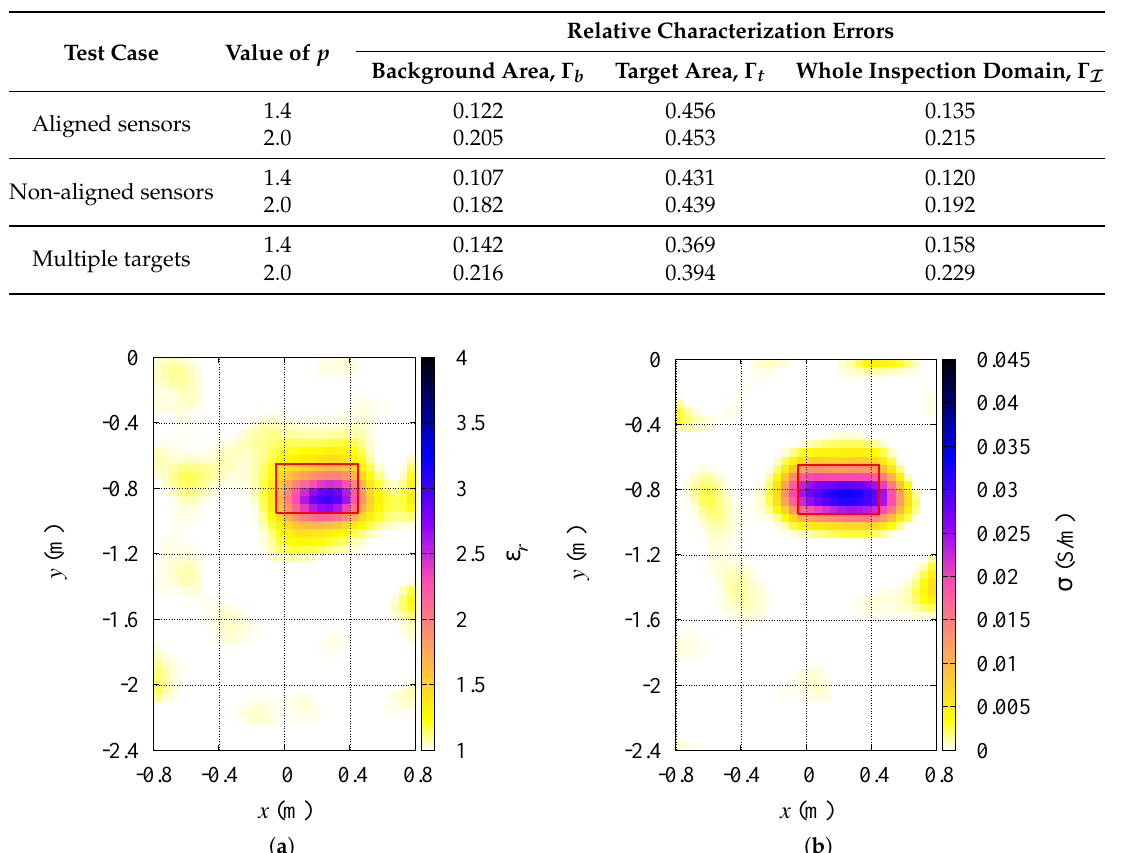
Table 2. Relative Errors on the Dielectric Characterization of the Targets in Cases of Aligned Sensors, Non-Aligned Sensors and Multiple Targets in the Investigation Area.